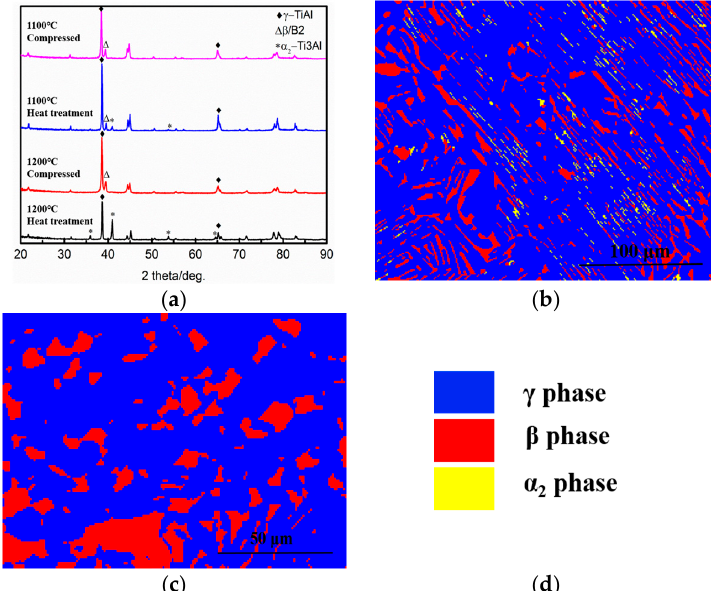
Figure 4. ( a ) X ‐ ray diffraction patterns of specimens deformed at strain rate of 0.001 s − 1 and heat treatment for 1200 s; phase map corresponds to ( b ) heat treatment at 1200 °C for 1200 s; and ( c ) deformed at 1200 °C.